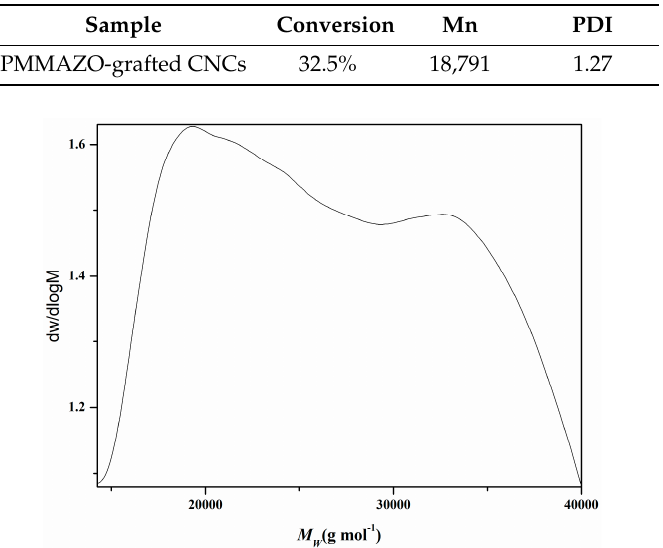
Figure 5. The molecular weight distribution of PMMAZO which cleaved from the PMMAZO-grafted CNCs. Table 1. Conversion, molecular weights, and polydispersities of grafted polymers during